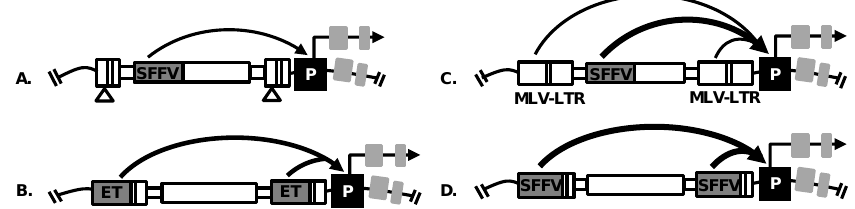
Figure 3. Retroviral vectors used in insertional mutagenesis screens to dysregulate nearby proto-oncogene via known mechanisms including enhancer-mediated activation of gene promoters (P). ( A ) Prostate cancer screen: Self-inactivating LV vector used to identify androgen-independent prostate cancer driver genes; ( B ) Hepatocellular carcinoma screen: LV vector with a hepatocyte-specific promoter (enhanced transthyretin, ET) in the LTR used to identify genes that drive hepatocellular carcinoma progression; ( C ) Breast cancer screen: γ RV vector with MLV-derived LTR and with a strong internal spleen focus forming virus (SFFV) promoter used to identify breast cancer metastasis driver genes; ( D ) Drug resistance screen: LV vector with SFFV promoter in the LTR used to identify drug resistance genes in HER 2+ breast cancer and pancreatic